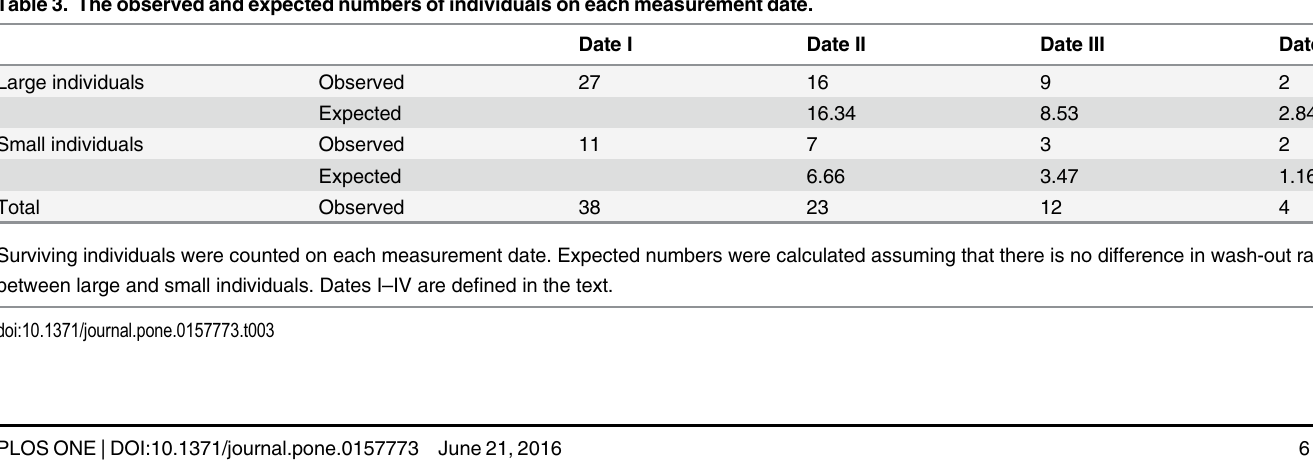
Table 3. The observed and expected numbers of individuals on each measurement date.